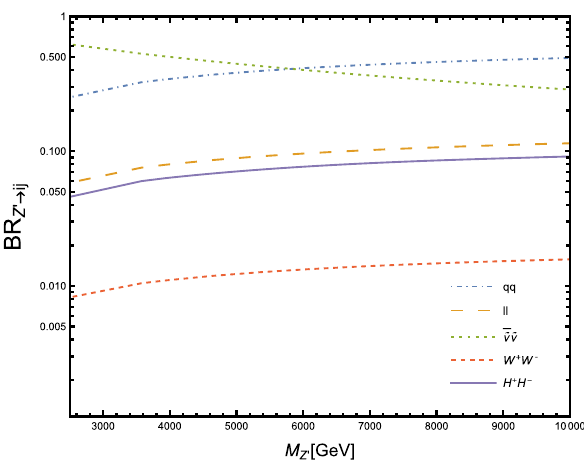
Fig. 9 Z (cid:2) branching ratios as a function of M Z (cid:2) for the most relevant channels: qq , ¯ ll , ˜ ν ˜ ν , W + W − , and H + H − . Here λv D = 1